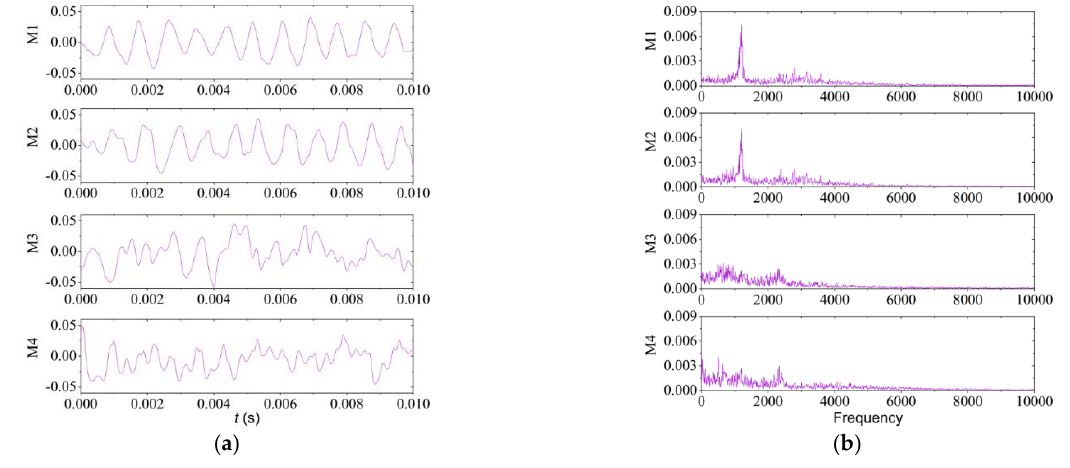
Figure 7. Time coefficients of the modes in time and frequency domains. ( a ) The first four modulus time coefficients. ( b ) Frequency-domain plots of time coefficients.